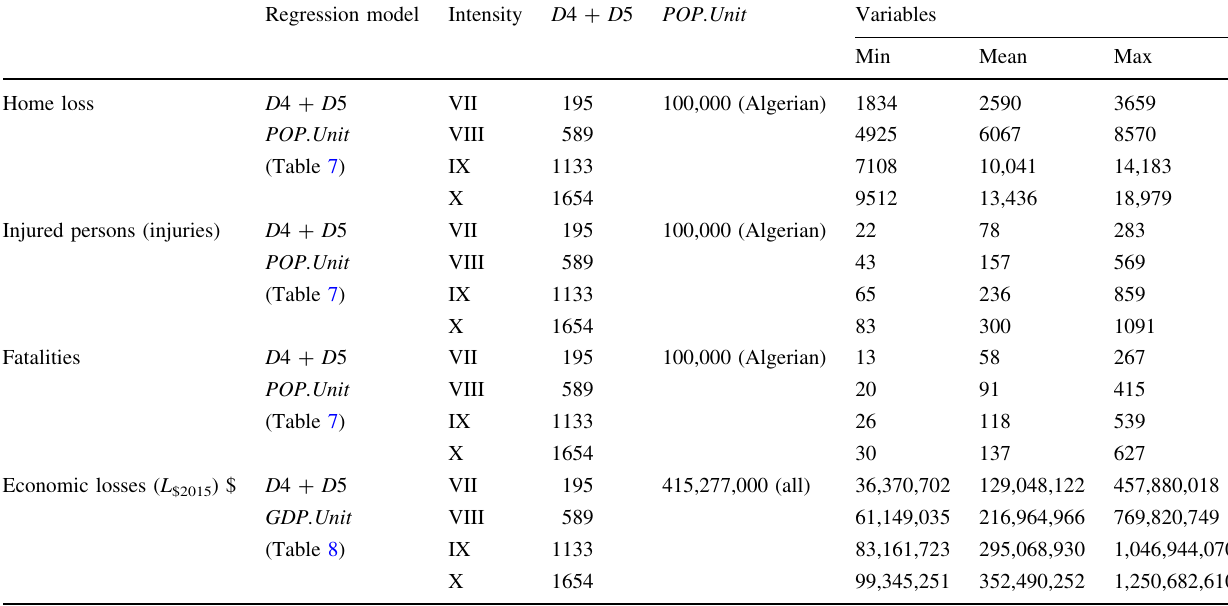
Table 9 Home loss, injuries, fatalities, and economic losses ( L $2015 ) computed in Constantine for macroseismic intensities VII–X using D 4 ? D 5 as a hazard-related variable and POP.Unit or GDP.Unit as exposure-related variable, respectively Regression